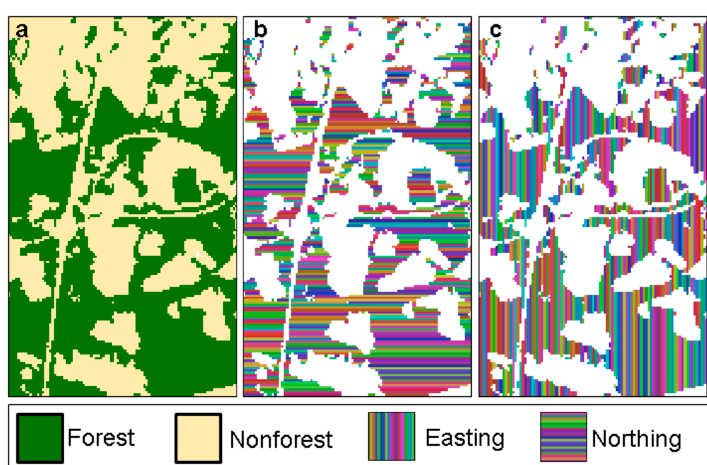
Figure 6. Example of inputs to the traversal width / length (TWL) metric. Continuous north-south and east-west strips are created across forested portions of the image using ArcGIS software. ( a ) The forest (green) and nonforest (yellow) land cover classes on a portion of the NLCD image from the PG study area. ( b ) The east-west and ( c ) the north-south strips used in the calculation of TWL (Equation (3)).